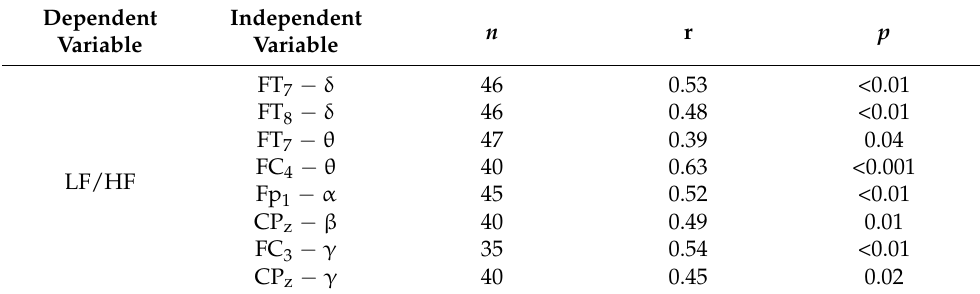
Table 11. Significant associations between electroencephalography variables and the low/high frequency heart rate variability ratio of train drivers.